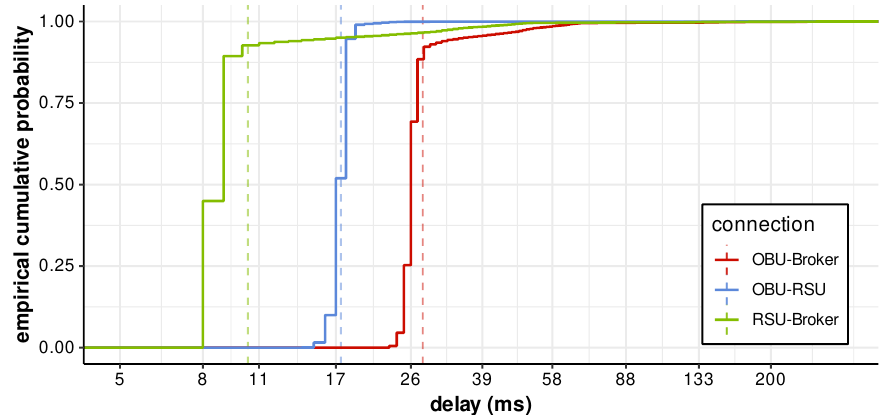
Figure 10. Empirical CDF representation of the OBU (Facilities layer) to RSU (Facilities layer) to cloud broker (listening client) message delay with the RSU with a fiber optics connection to the Internet. The vertical dashed lines represent average